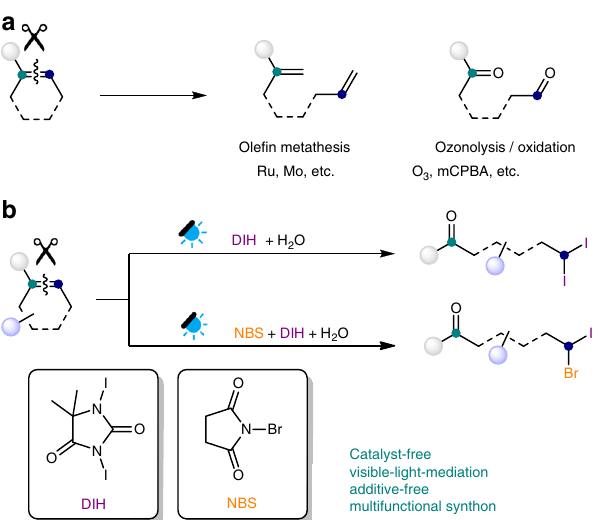
Fig. 1 Deconstructive functionalization of alkenes. a Common strategies for C = C bond cleavage. b Visible-light-mediated deconstructive oxidative geminal dihalogenation of trisubstituted alkenes (this work). DIH 1,3- diiodo-5,5-dimethyl-hydantoin, NBS N -bromosuccinimide, mCPBA meta - chloroperoxybenzoic acid.